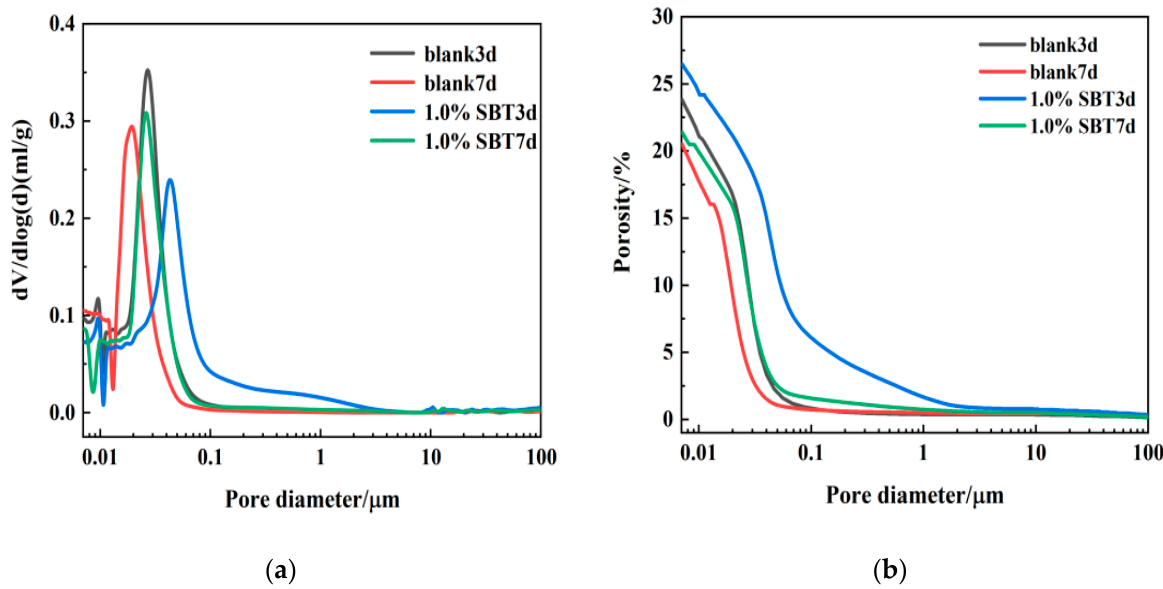
Figure 8. 3 d and 7 d mercury injection maps of blank cement paste group and 1.0%SBT. ( a ) is the aperture distribution diagram of each specimen; ( b ) is the cumulative aperture distribution diagram of each specimen.